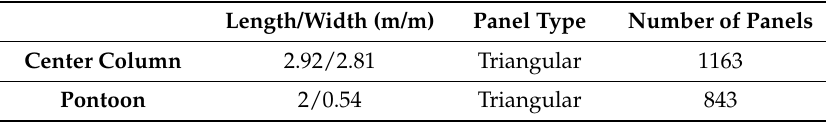
Table 3. Panel properties of the MIT/NREL TLP wetted